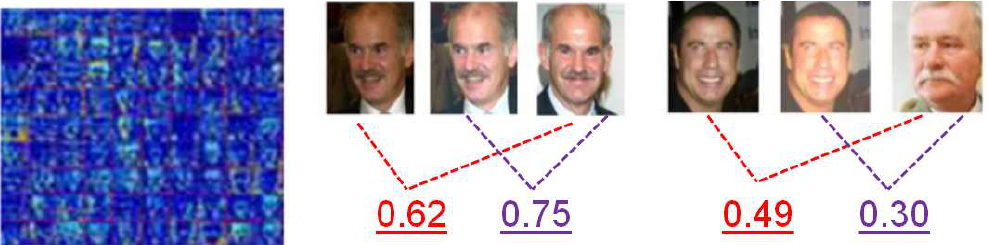
Figure 11. The extracted semantic feature and their responses to individuals, the value stands for cosine similarity